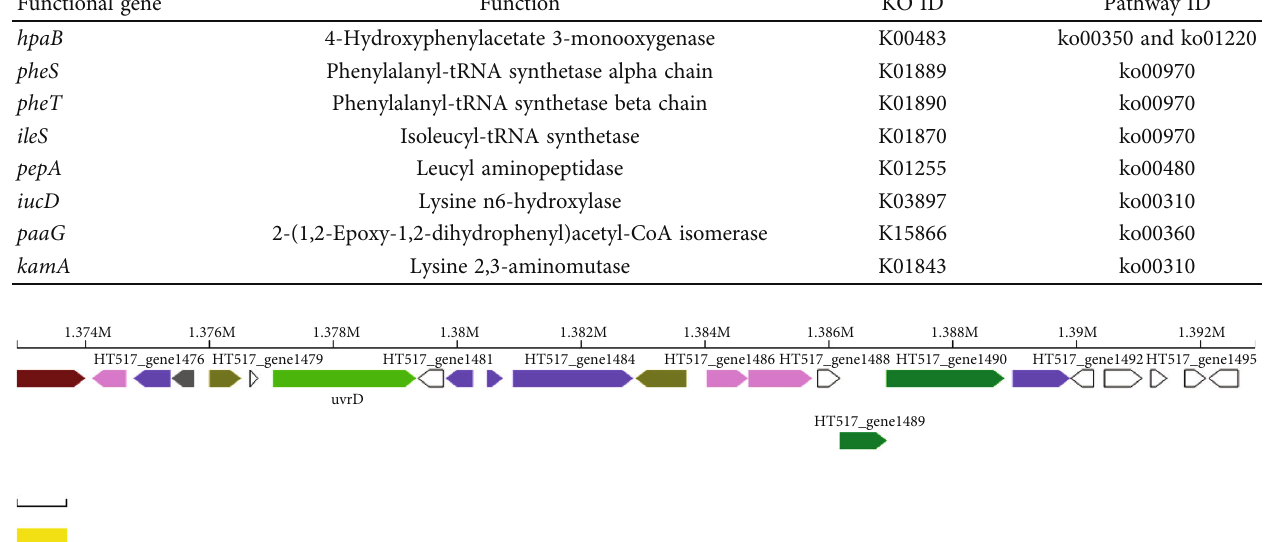
Table 4: Functional genes and metabolic pathways of alkaloid secreted by Bacillus megaterium. Functional gene